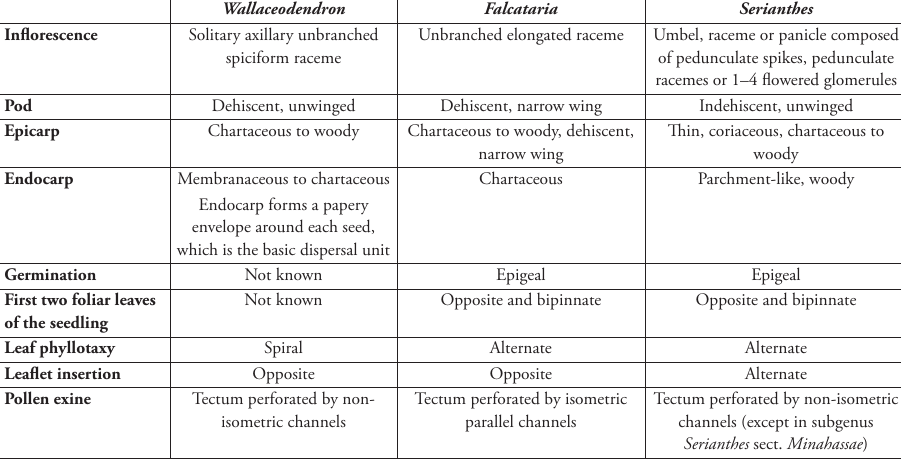
Table 5. Morphology of Serianthes , Falcataria and Wallaceodendron, based on Fosberg (1960), Nielsen (1992), Nielsen et al. (1983, 1984a, b) and Verdcourt (1979).